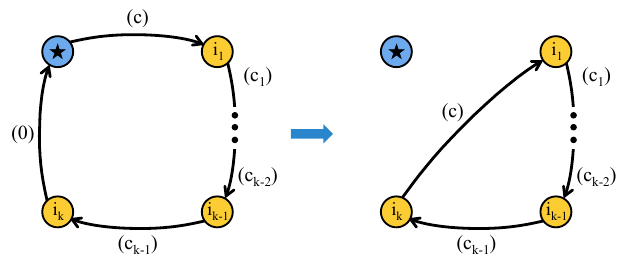
Figure 18. Mutation of a superpotential term with a 2-path giving rise to a meson.